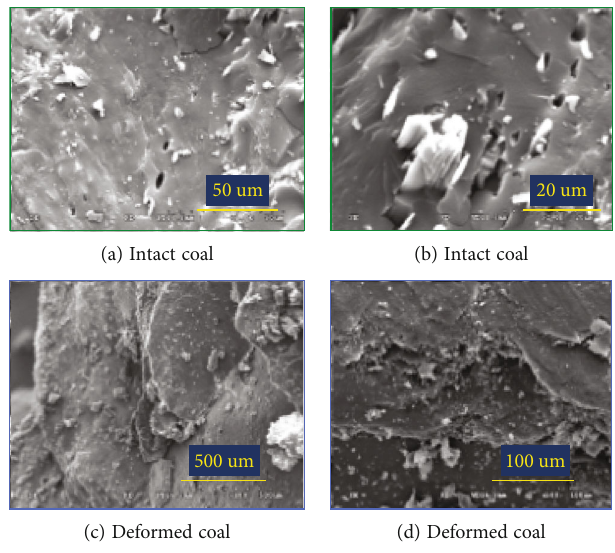
Figure 2: SEM results of coal